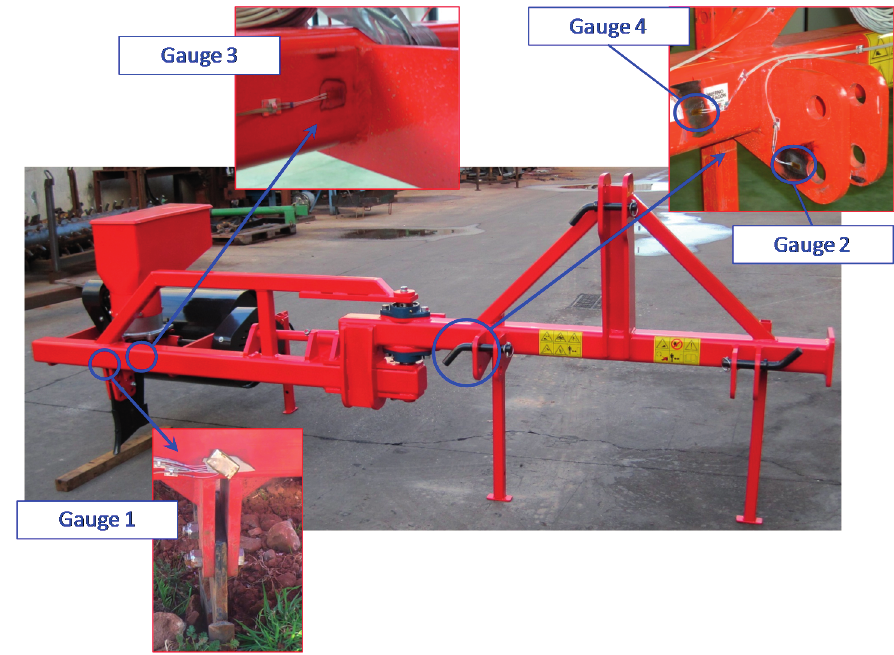
Figure 4. Strain gauge locations on the agricultural implement prototype during the experimental